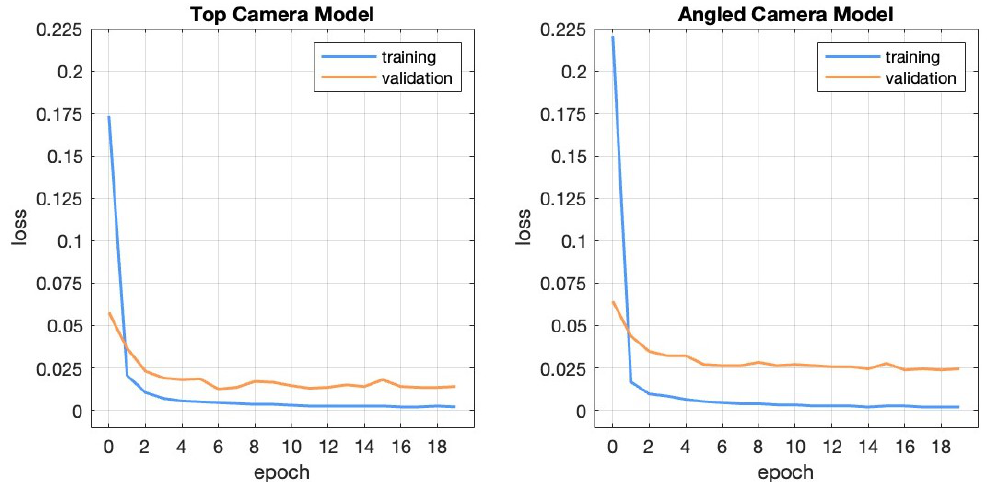
Figure 6. Training Loss (MSE) for the R-50 based network trained on images from the top ( left ) and angled ( right ) cameras